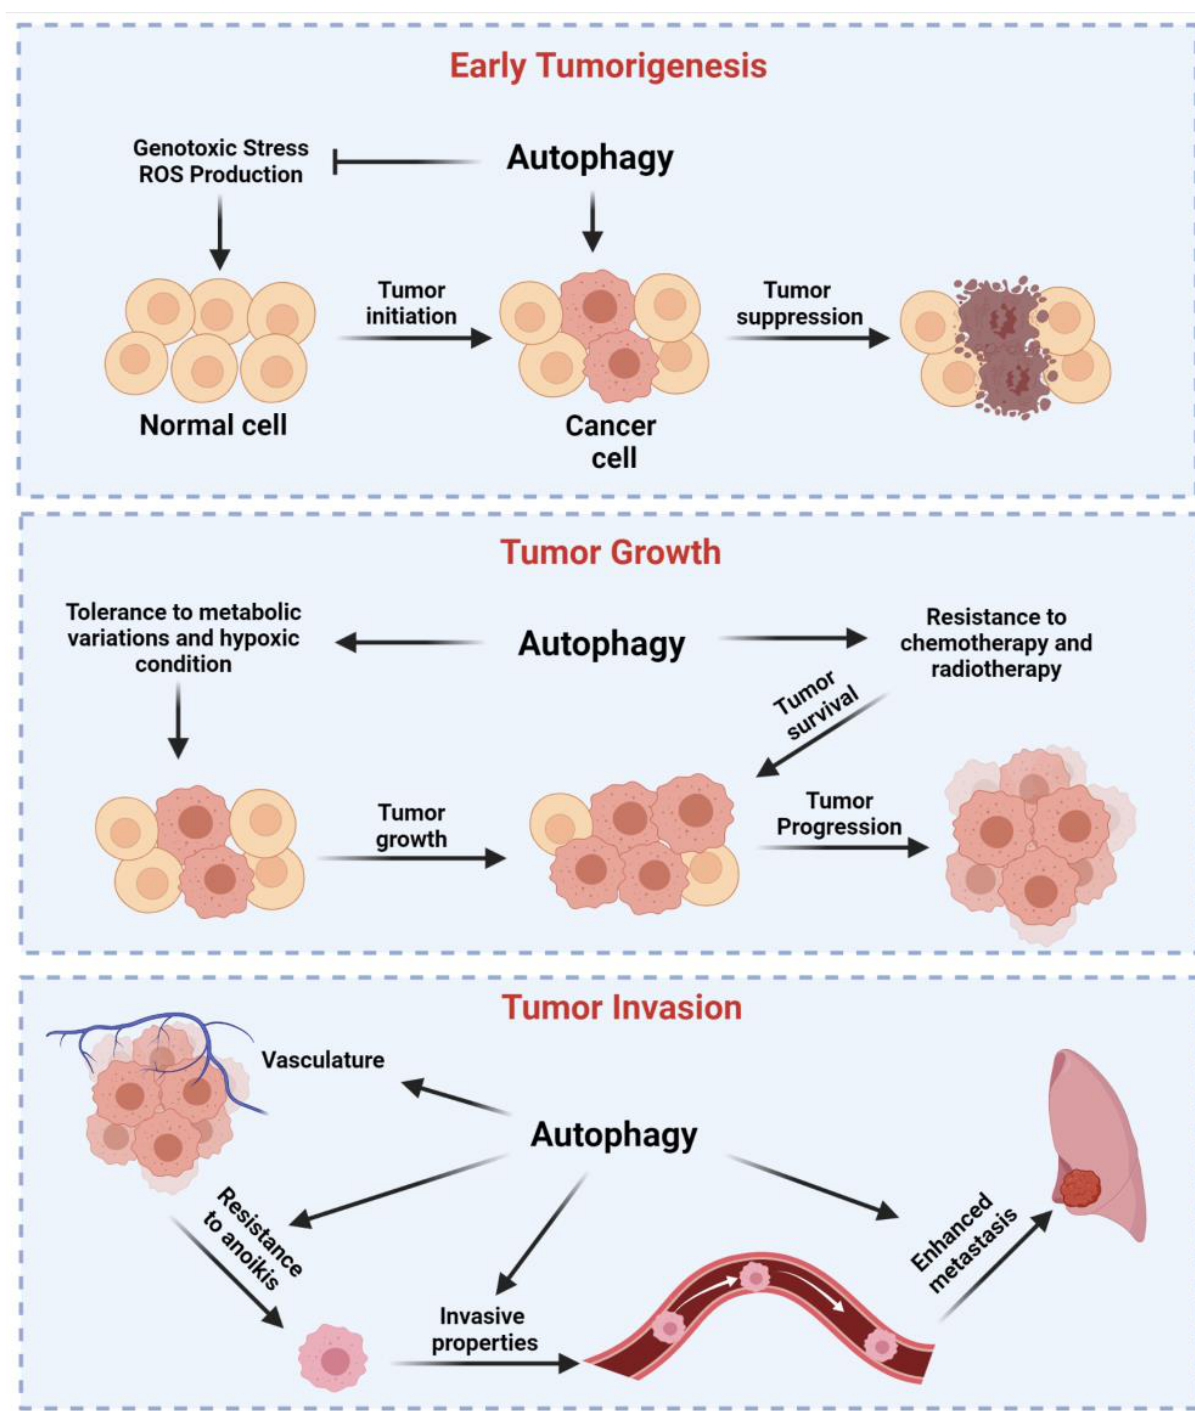
Figure 2. Autophagy role during the different stages of tumorigenesis. Different evidence suggests that, during tumor initiation, autophagy has anti-cancer properties since it protects from agents that may provoke DNA damaging. Furthermore, autophagy has been found to increase the mortality of cancerous cells. Opposingly, autophagy drives the tumor growth of established tumors, enhances cancer cell survival in unfavorable conditions (such as nutrient restriction and hypoxic conditions), and permits cancer cells to evade escape from cancer therapy. Additionally, autophagy promotes the tumor cell metastasis by increasing vascularization and invasive properties and by reducing cell death events against circulating cancer